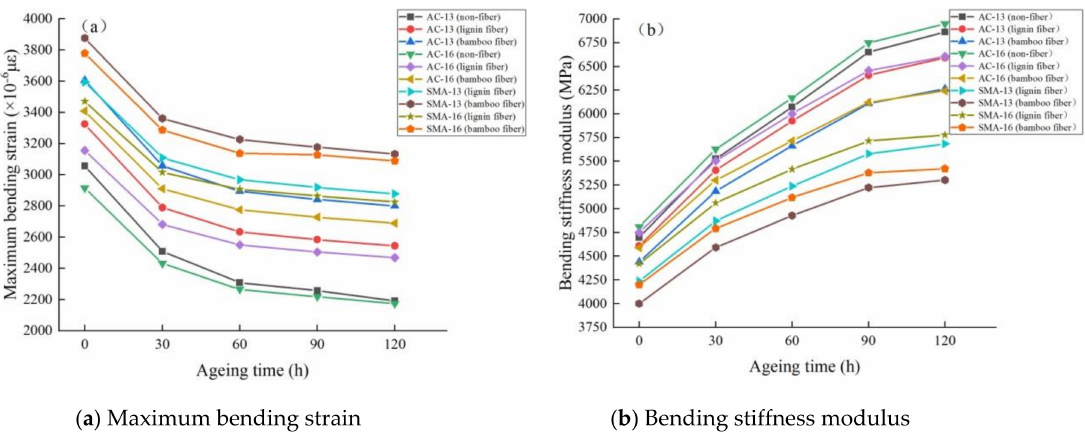
Figure 5. Low-temperature performance test results of fiber asphalt mixture under different ageing